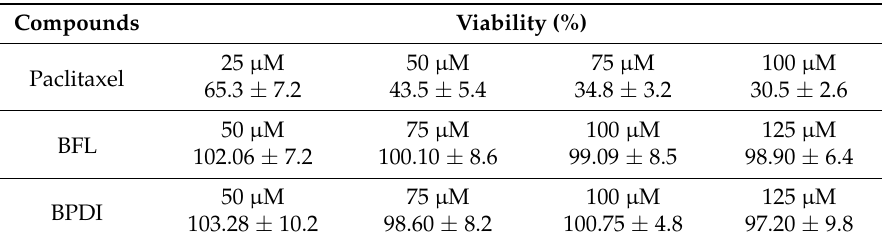
Table 1. Cytotoxicities of BFL and BPDI in Caco-2 cells.